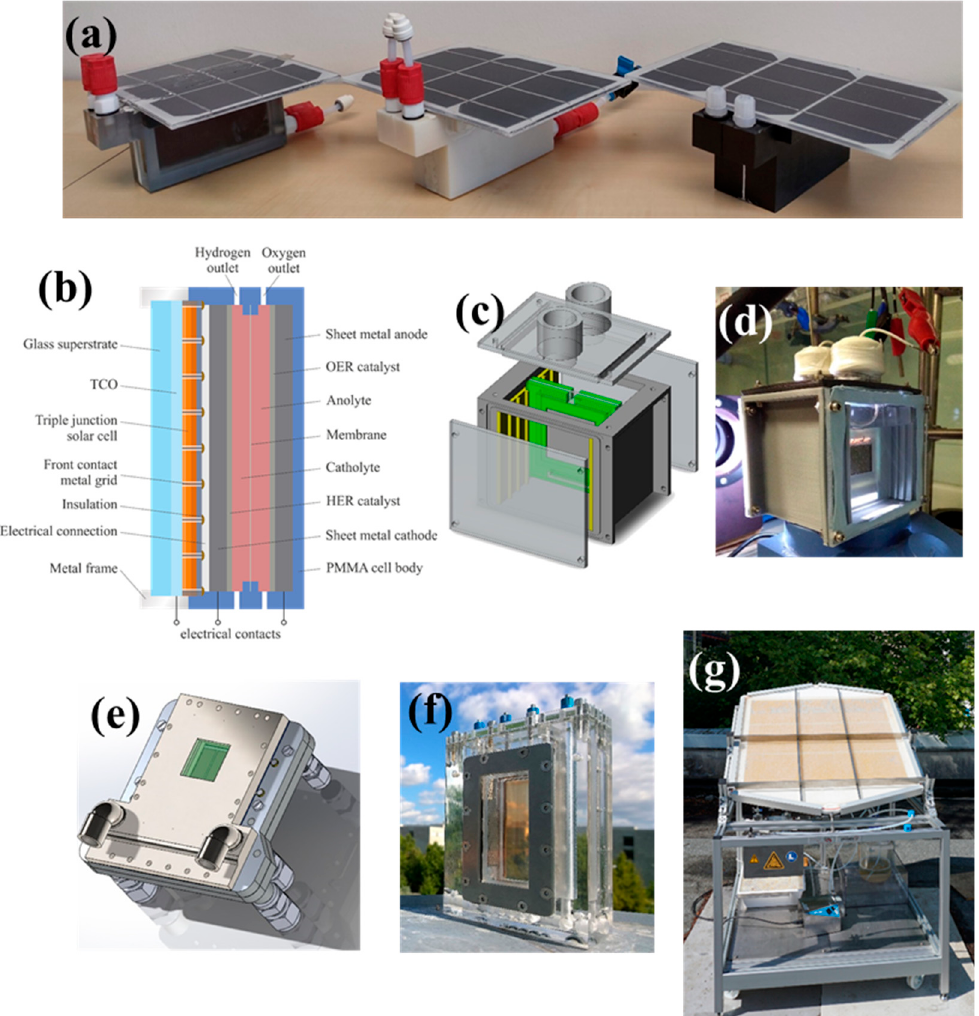
Figure 1. Images of a selection of fully functional photo-electrochemical (PEC) laboratory prototypes showing the different means of hermetic sealing used. PEC devices ( a ) with the body made out of various three-dimensional (3-D) printed acrylic based polymers and sealed using only epoxy and sealing gaskets in the authors’ laboratory. Machined poly methyl methacrylate (PMMA) body ( b ) with edge sealing done using epoxy adhesive (image courtesy of F. Finger and J. Becker, Forschungszentrum Jülich, Germany); Drawing ( c ) and photograph ( d ) of a 3-D printed polylactic acid (PLA) encasement using screw compression with the peripheral of the glass window sealed with a reusable pressure sensitive adhesive (figures courtesy of Virgil Andrei, University of Cambridge, United Kingdom).